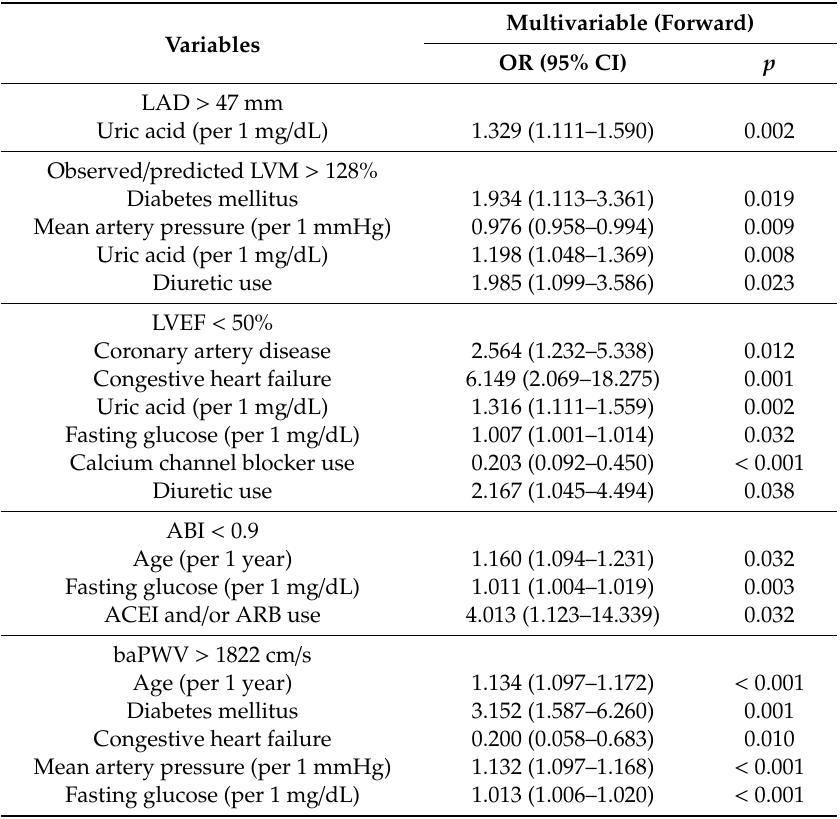
Table 2. Determinants of abnormal ABI, baPWV and echocardiographic parameters of study patients using binary logistic regression